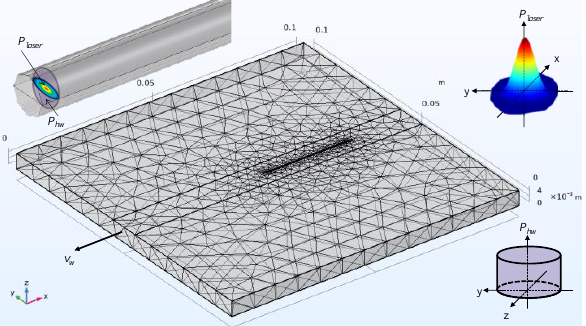
Figure 5. Schematic representation of the applied simulation conditions: meshing, weld seam geometry, heating power and laser power distribution.